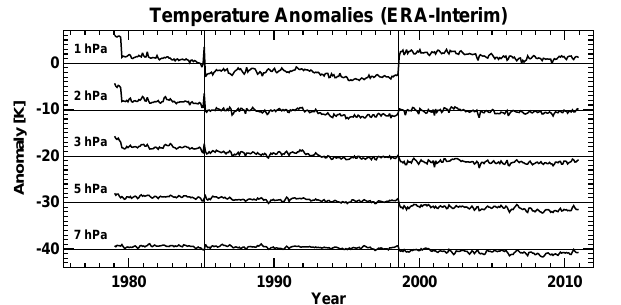
Fig. 1. Global and monthly mean ERA-Interim temperature anoma- lies at the top five pressure levels in the stratosphere. The curves at 2, 3, 5 and 7hPa are shifted by 10K with respect to the curve above. The “jump times” in March 1985 and August 1998 are de- noted by the thin vertical lines. Tick marks on the horizontal axis denote January.